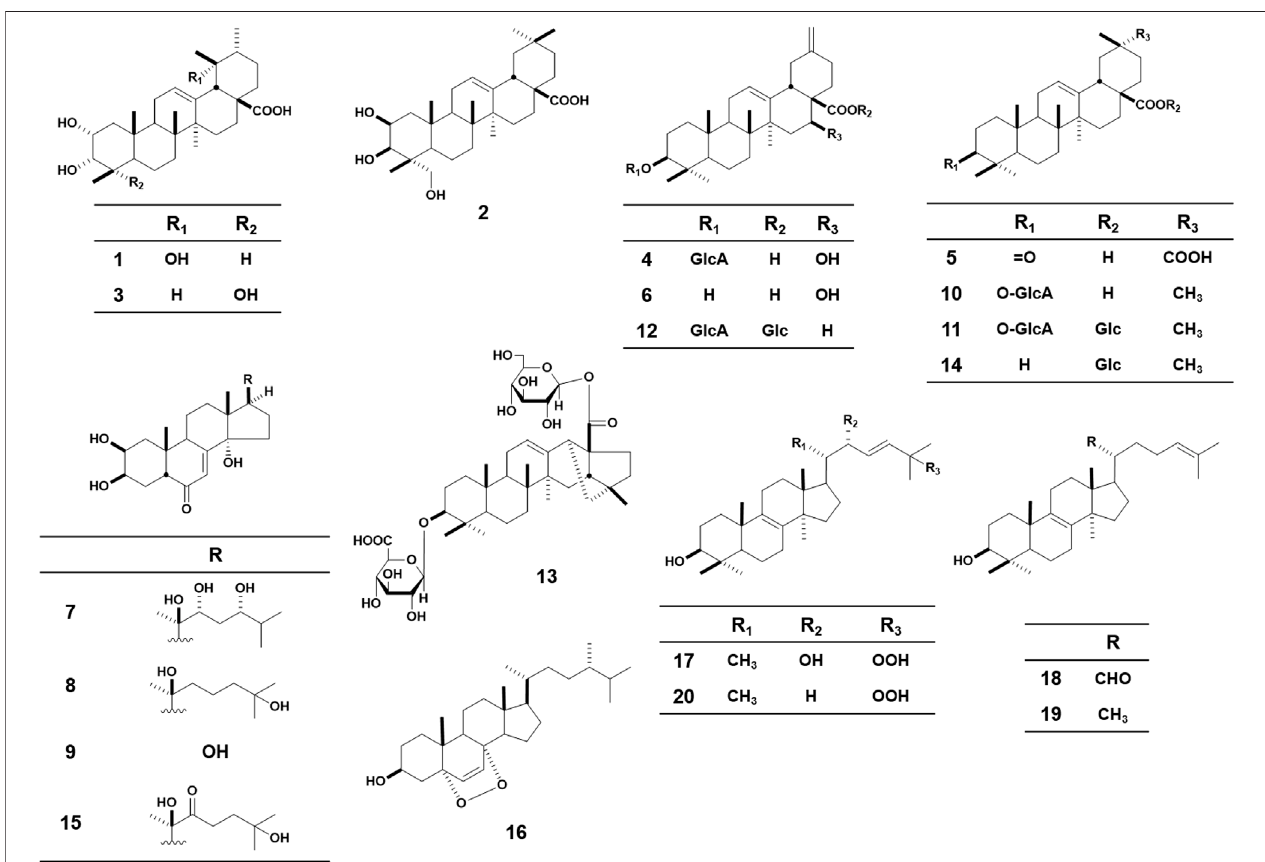
FIGURE 2 | Chemical structures of 20 triterpenes.